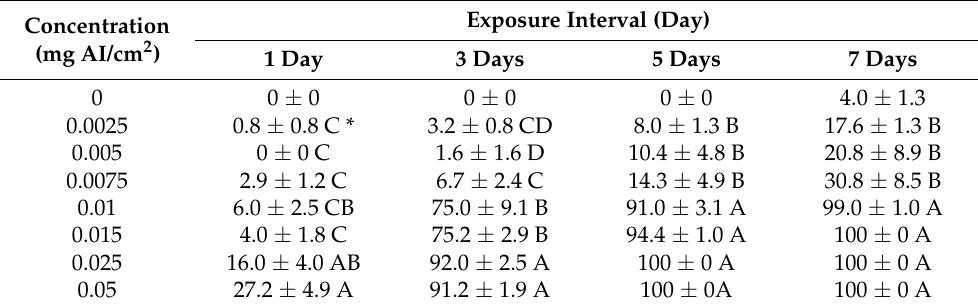
Table 2. Mean corrected mortality (% ± SE) of Acanthoscelides obtectus adults after 1-, 3-, 5- and 7-day exposure to concrete surface treated with spinetoram at eight different concentrations.